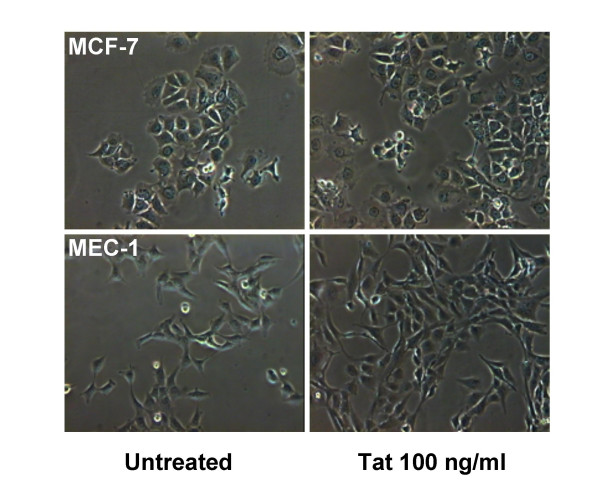
Monolayers of MCF-7 and MEC-1 cells cultured in low-serum medium and treated or not with extracellular Tat101aa (100 ng/ml for 36 hours). Increased numbers of cells can be observed in Tat-treated cultures as compared to untreated control cultures. Phase contrast; microscopic fields taken with a 10× objective.